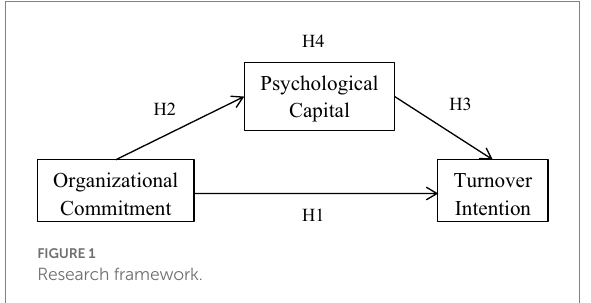
FIGURE 1 Research